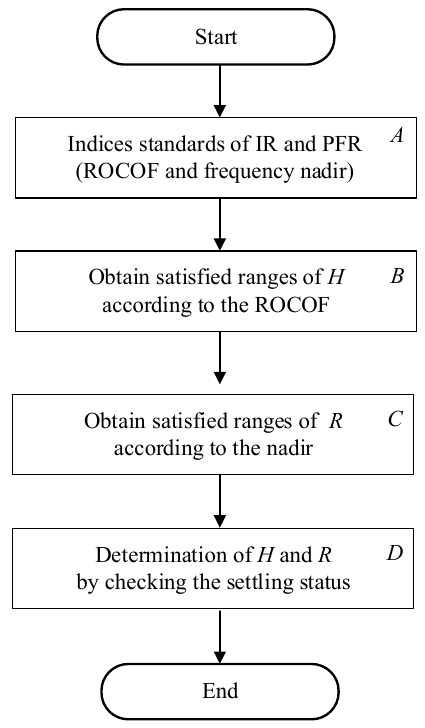
Figure 13. Flowchart of adaptive parameter tuning. Table 4. Predetermined standards of performance indices.